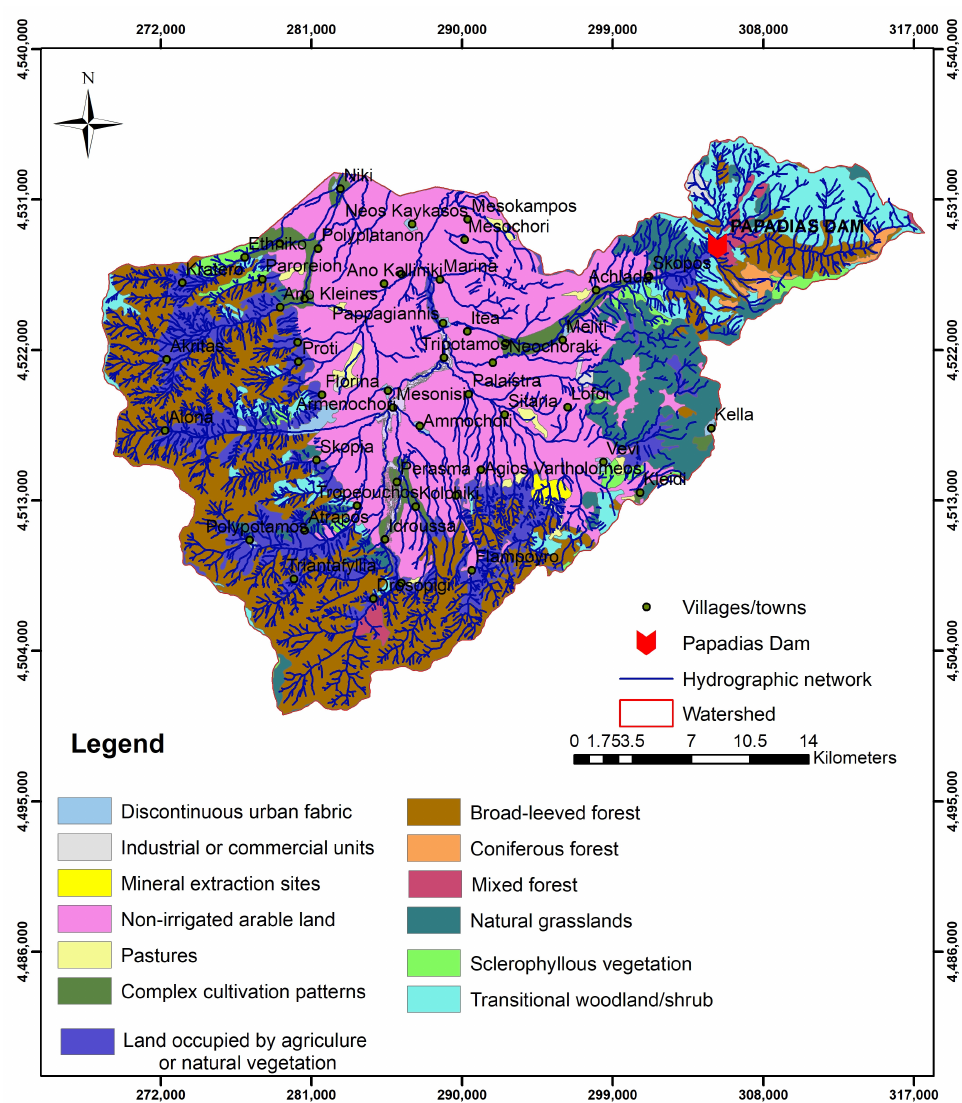
Figure 2. Land cover of the Florina basin. Table 1. Florina hydrological basin land cover (CORINE 2018).